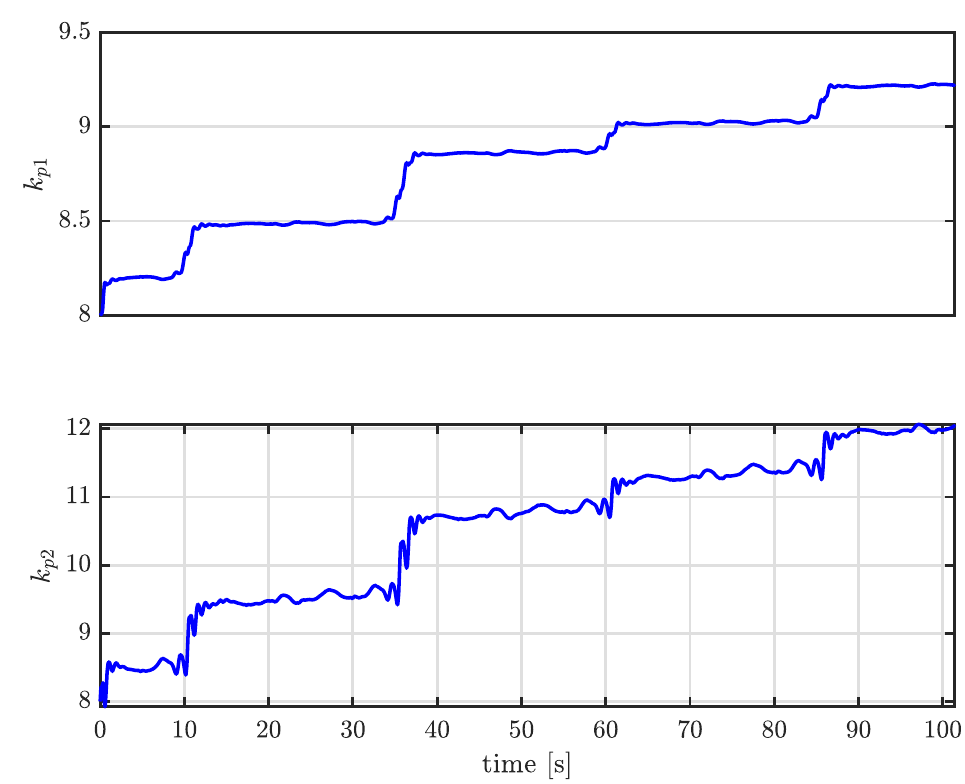
Figure 13. Trajectory tracking (Case III-experiment).